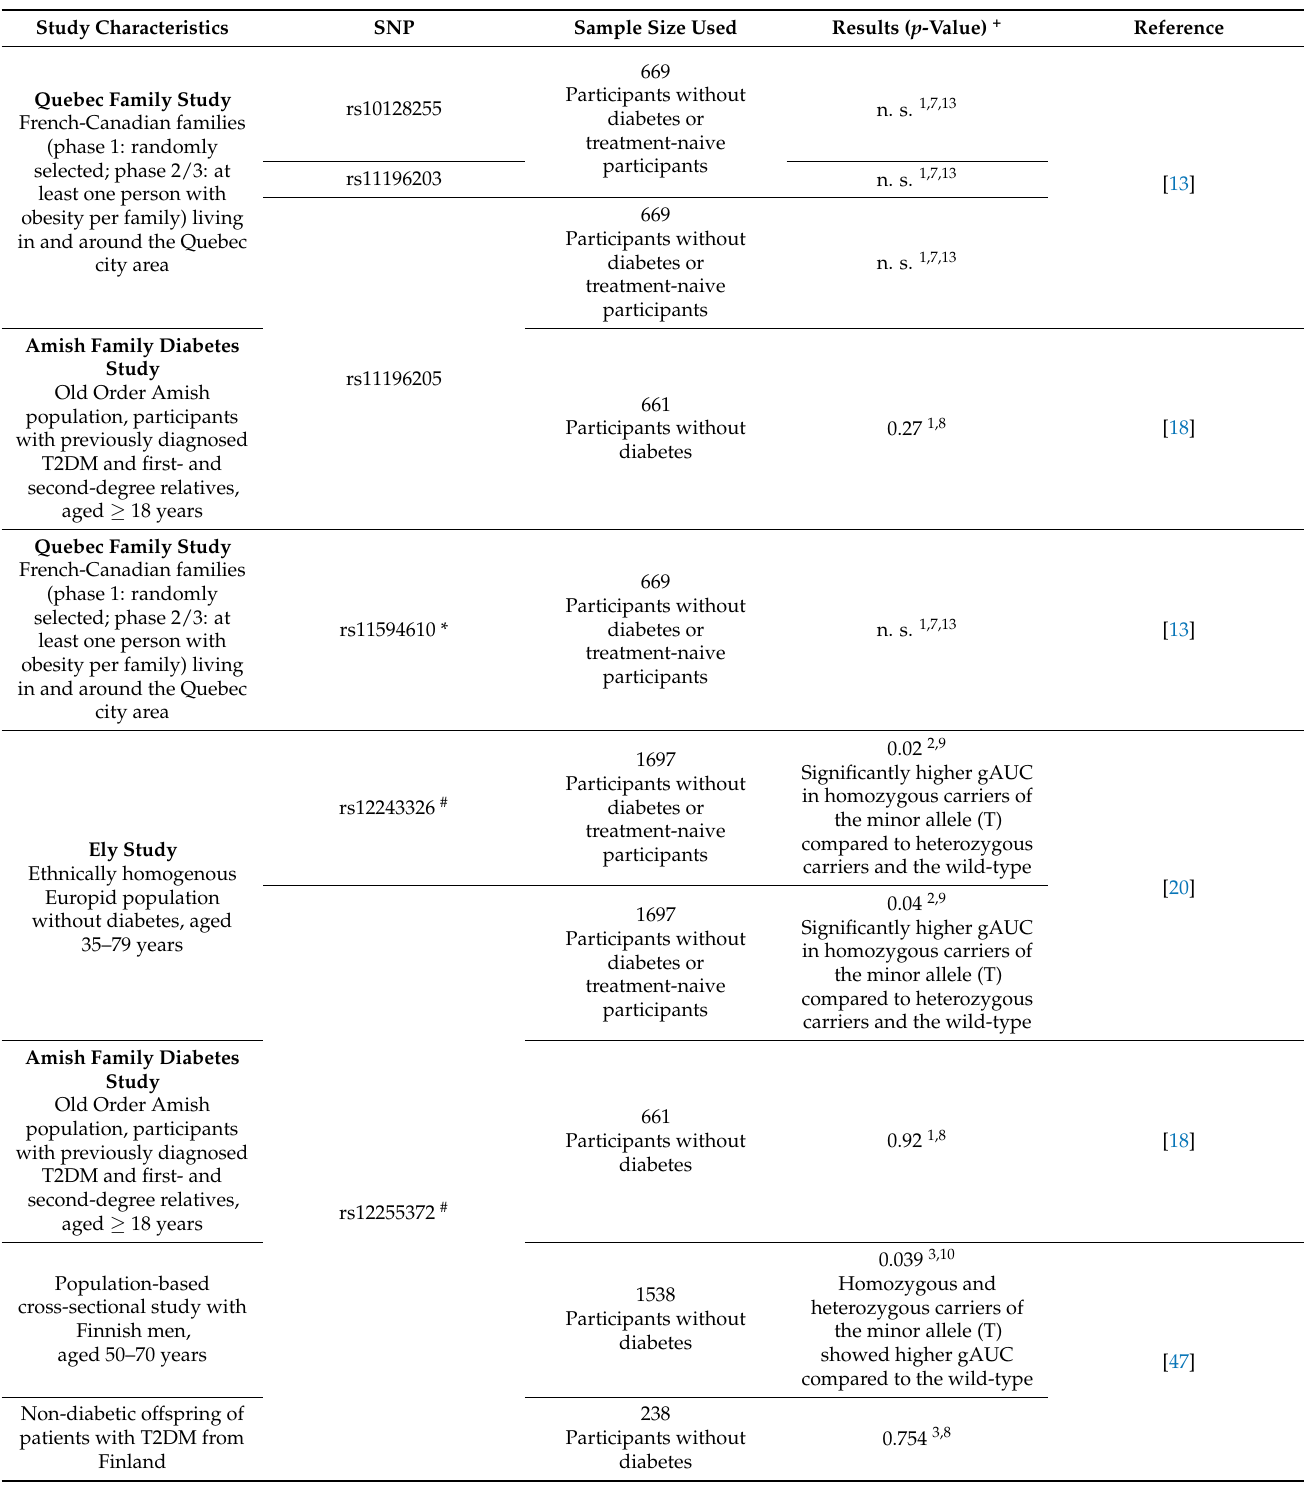
Table 1. Associations between transcription factor 7 like 2 ( TCF7L2 ) SNPs and gAUC after an OGTT in